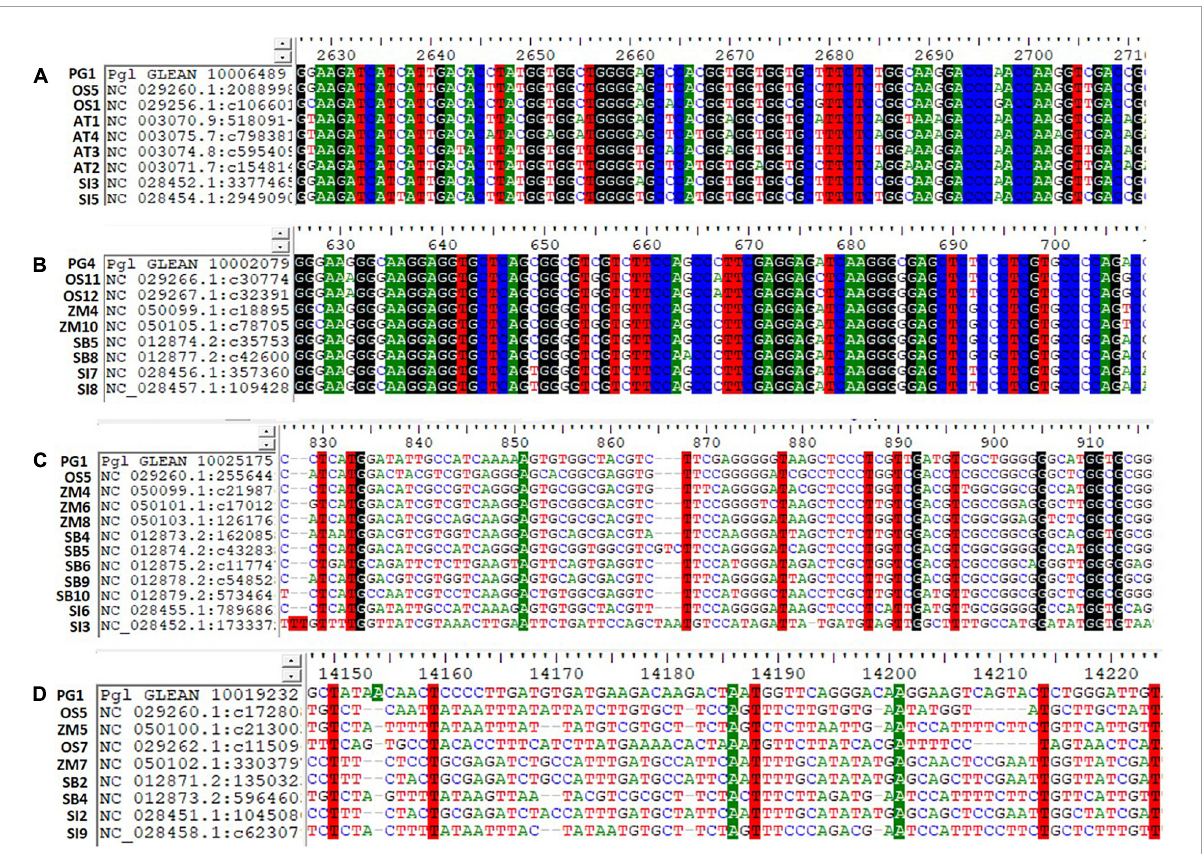
FIGURE5 Haplotypes representation for the top identified Fe and Zn genes across Arabidopsis and five food crops (AT, Arabidopsis thaliana ; PG, Pennisetum glaucum ; OS, Oryza sativa ; ZM, Zea mays ; SB, Sorghum bicolor ; and SI, Setaria italica ). (A) Pgl_GLEAN_10006489 (SAM synthase) with ortholog sequences of Arabidopsis spp. and two food crops showing highly conserved regions of a gene, (B) Pgl_GLEAN_10002079 (Ferritin) with ortholog sequences of four food crops showing highly conserved regions of a gene, (C) Pgl_GLEAN_10025175 (O-methyltransferase activity) with ortholog sequences of four food crops showing higher variability regions with a few haplotypes of a gene, and (D) Pgl_GLEAN_10019232 (SAM transmembrane transporter activity) with ortholog sequences of four food crops showing higher variability regions with a few haplotypes of a